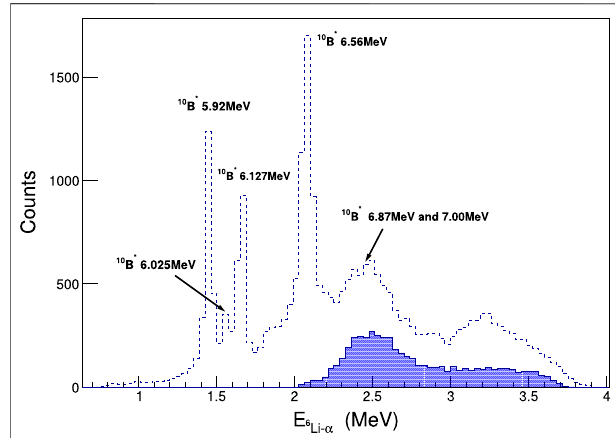
FIGURE3| Thespectrum ofE 6 withQF-cut.The fi lledsolidhistogram Li − α is restricted by the condition that the assumed intermediate breakup process 9 Be + 2 H → 9 Be + p + n is one criterion of the QF process. Without this restriction, the energy region of the QF process overlaps with that of the sequential decay via the 5.92, 6.025, 6.127, 6.56, 6.87 and 7.00 MeV 10 B levels (dashed histogram). The picture is adapted from ref. Wen et al.